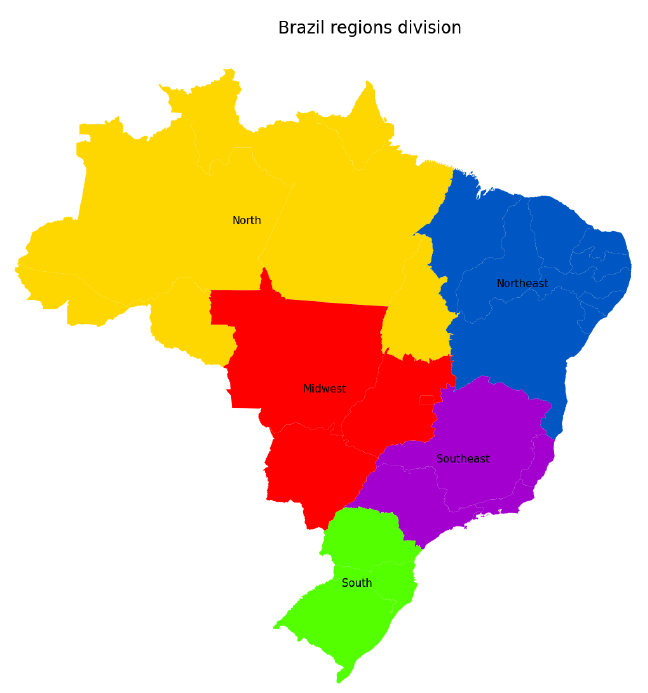
Figure 10. Brazilian regions.